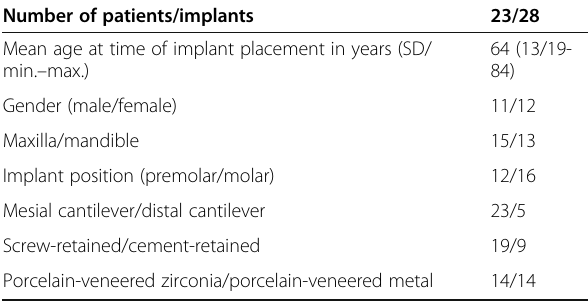
Table 1 Patient and treatment